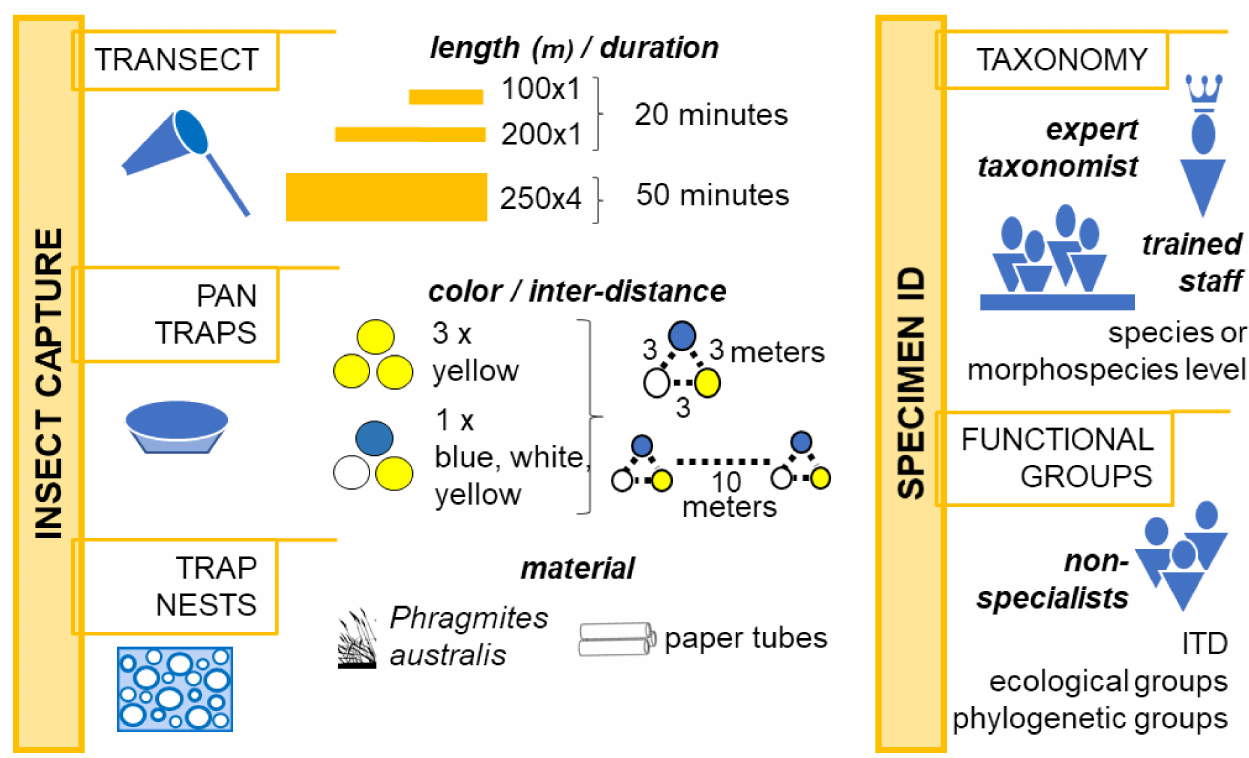
Figure 5. Study of pollinators. The two tasks for pollinator collection and specimen identification, as explained in Section